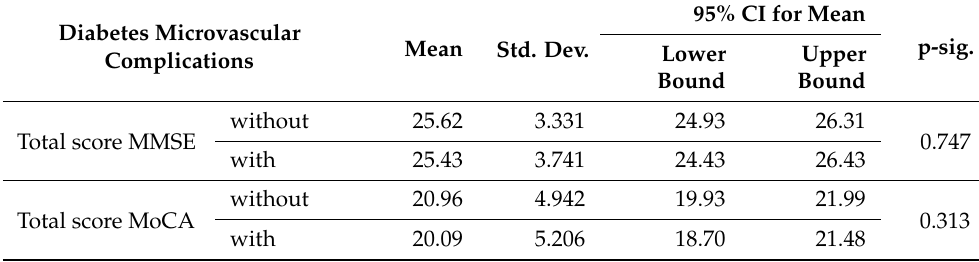
Table 6. Differences in MMSE and MoCA scores according to microvascular complications. Diabetes Microvascular